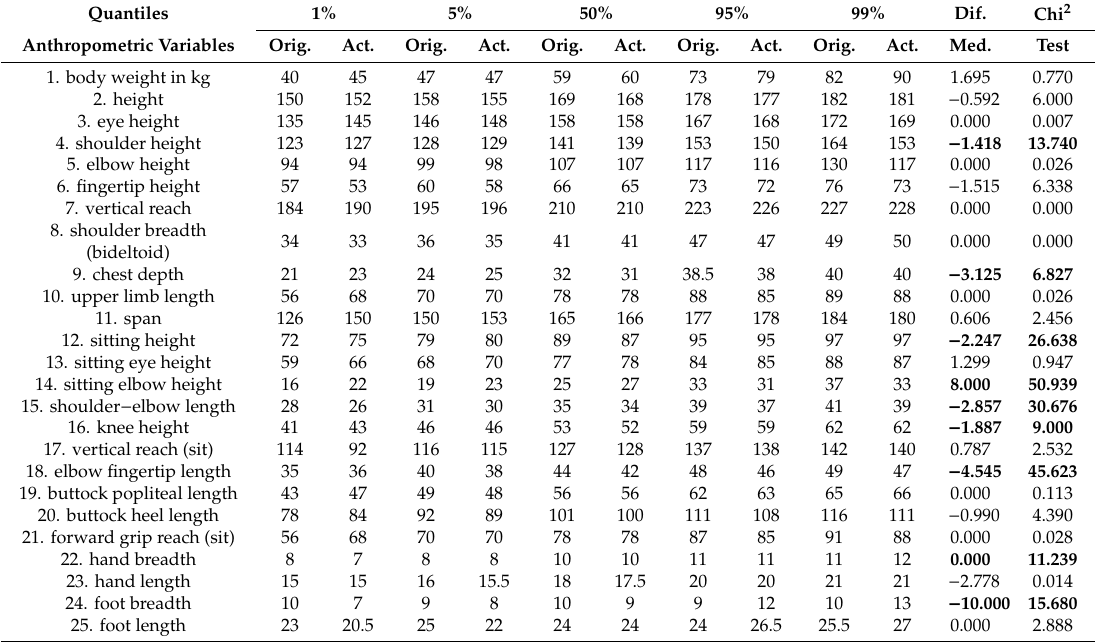
Table 5. Comparison of the original (the year 2004) and actual (the year 2018) quantiles of selected anthropometric variables of the female population in the Slovak